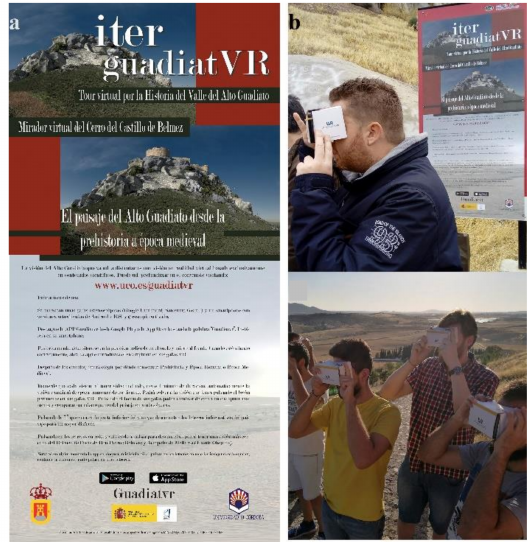
Figure 15. Lookout VR tools installed in the CCB. ( a ) Instructions for IOS and Google Play apps; ( b ) Using of GudiatVR app; Copyright “Ager Mellariensis” / AEI FEDER HAR 77136-R.